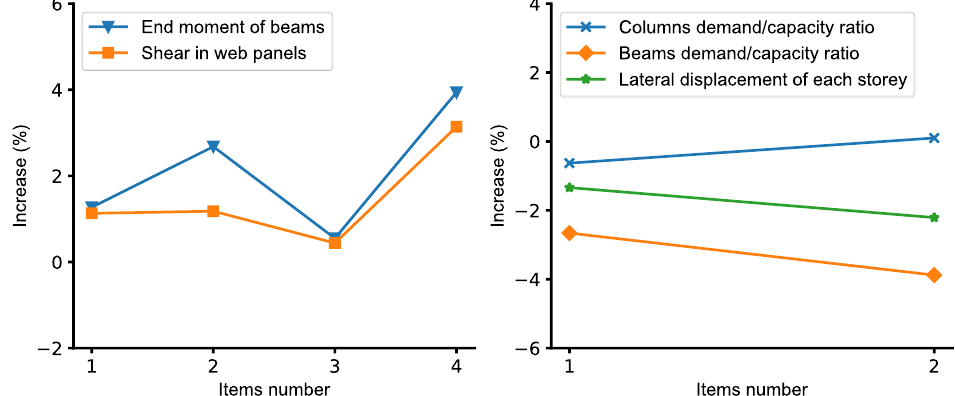
Figure 19. The relative difference for responses of the frame under the required and the obtained joints performance.